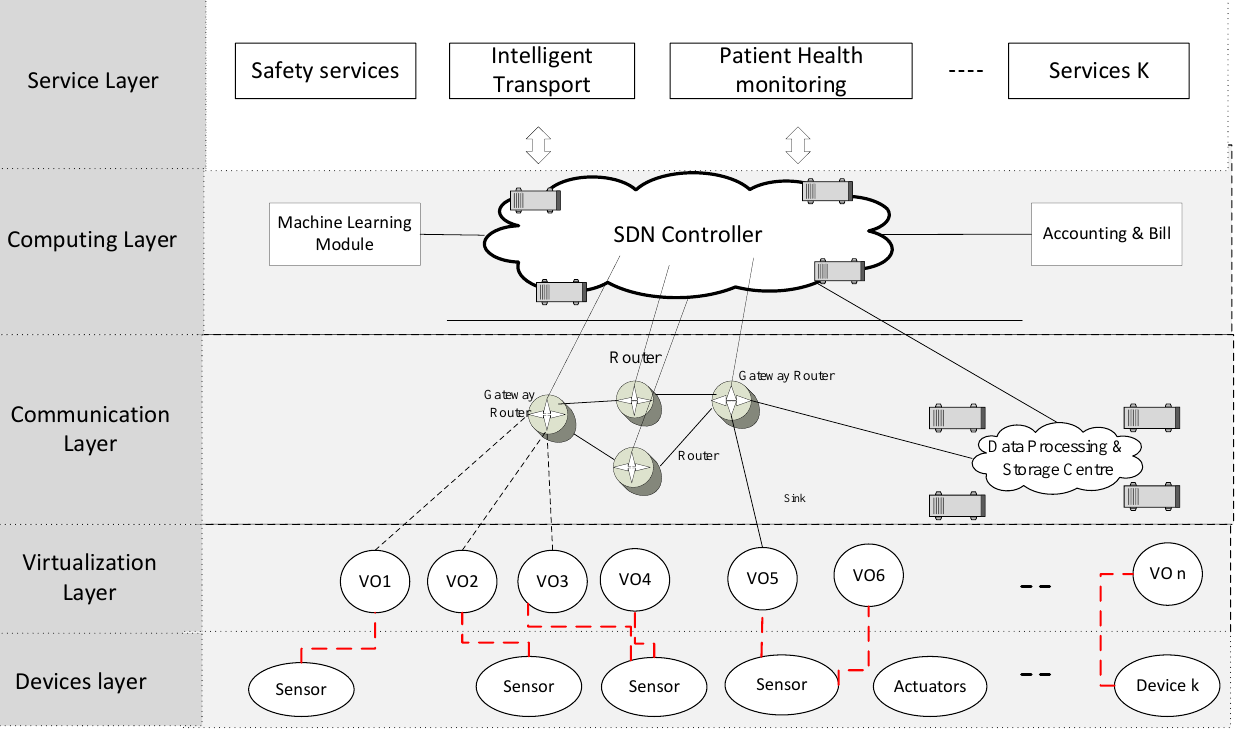
Figure 3. Conceptual IoT Architecture based on Intelligent SDN with Machine learning